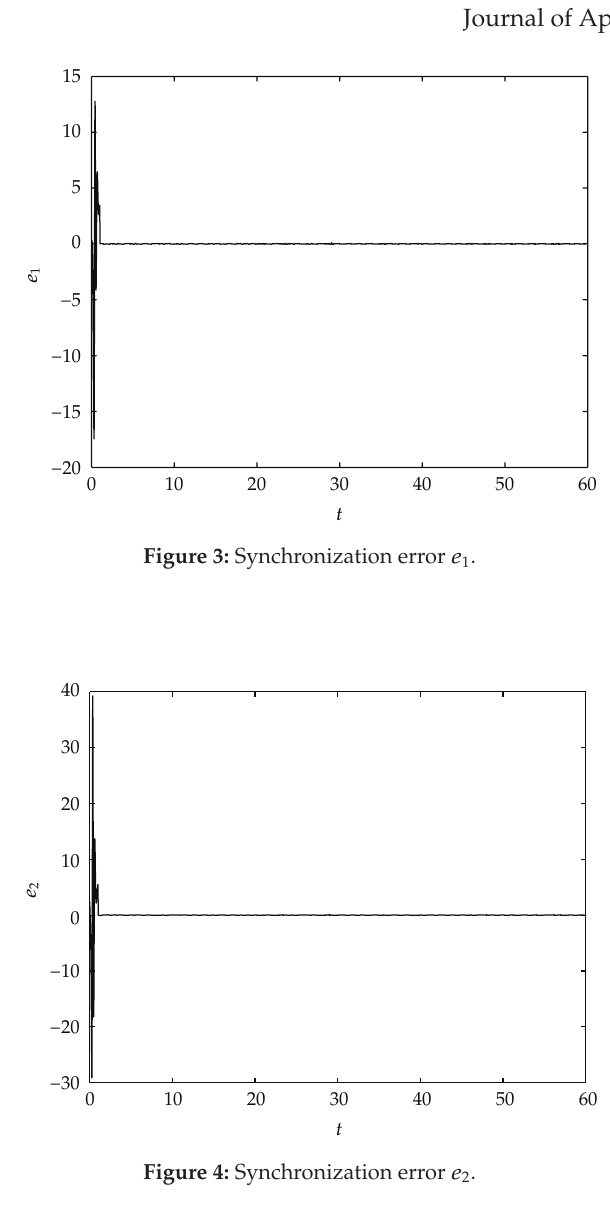
(cid:15) (cid:15) b 10 , (cid:15) c 10 , (cid:15) g 10 , and h 10 are depicted